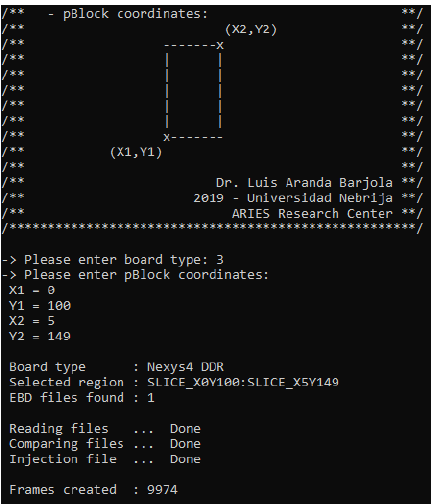
Figure 25. Interface ACME tool.